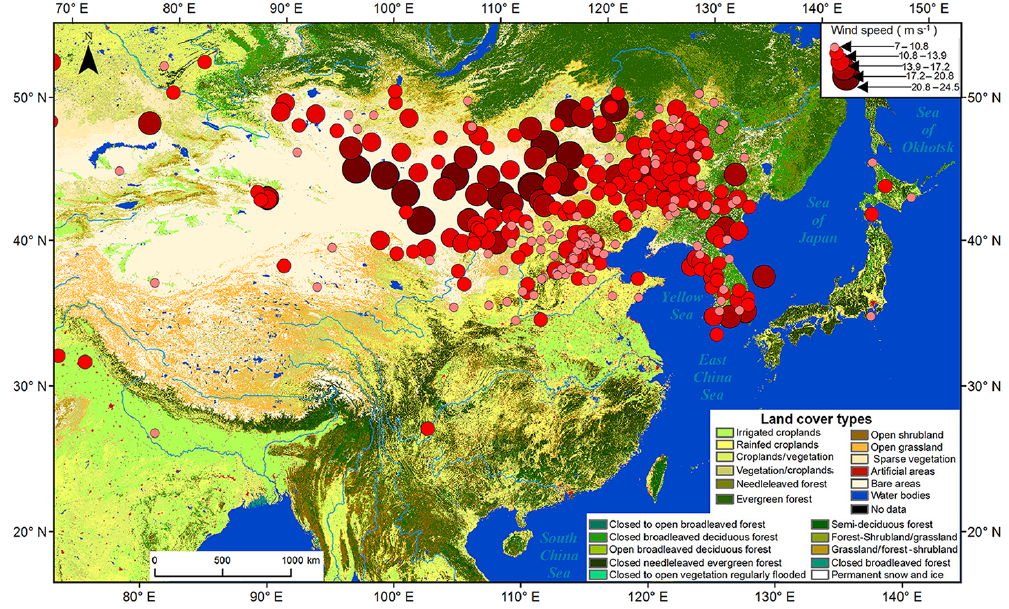
Figure 6. Maximum wind speed across East Asia during 2–7 May 2017. Land cover types in East Asia are derived from global land cover products published by the European Space Agency